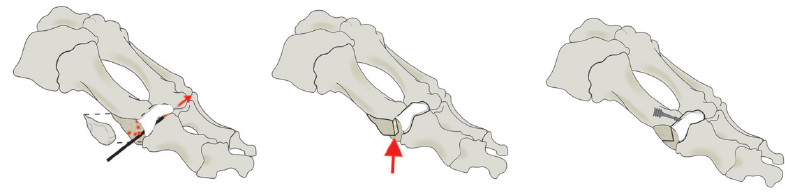
Figure 1. The process of chevron osteotomy. Figure provided by H.J.